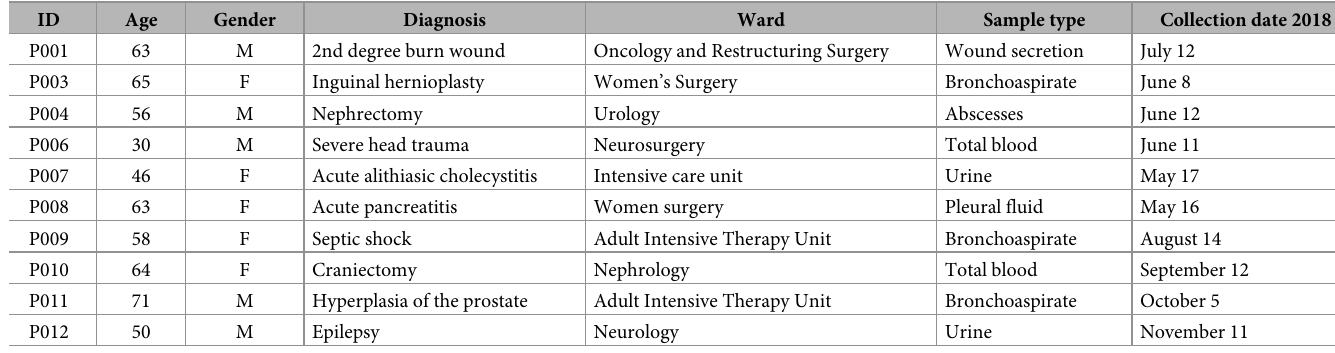
Table 1. Patients’ clinical